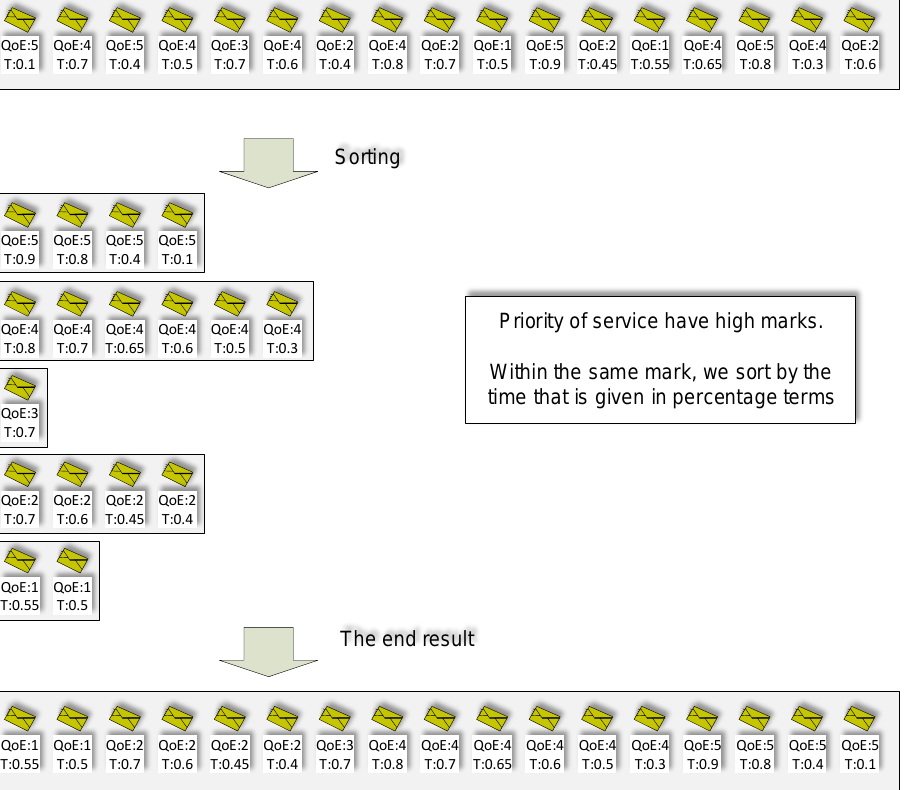
Figure 18. Proposed packet sorting method.